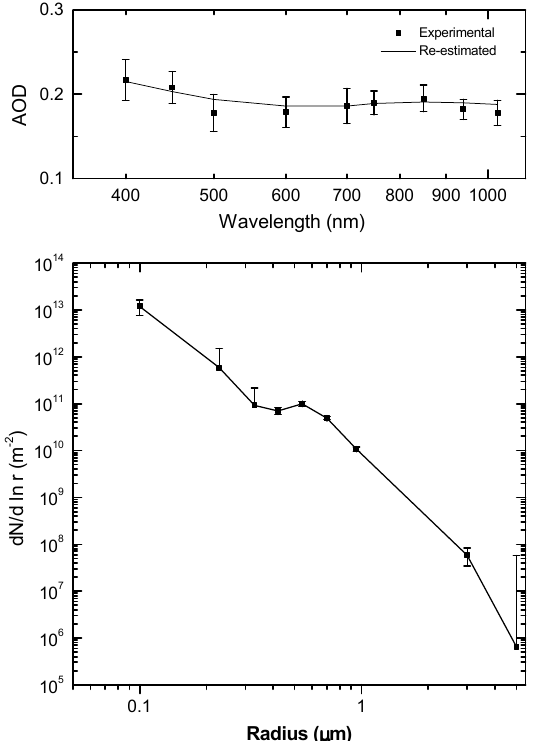
Fig. 2. Typical aerosol columnar number density - size distribution at Visakhapatnam (bottom panel). The top panel shows the exper- imental data (points with standard deviation) used in the inversion and re-estimated aerosol optical depths (solid line) retrieved from the obtained size